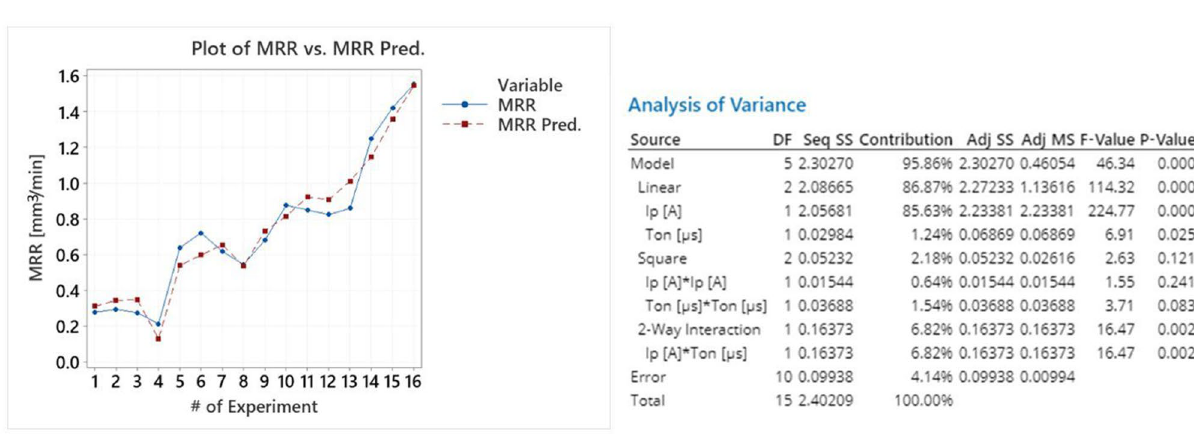
Figure 5. Main Effects Plot and Interaction Plot of MRR.